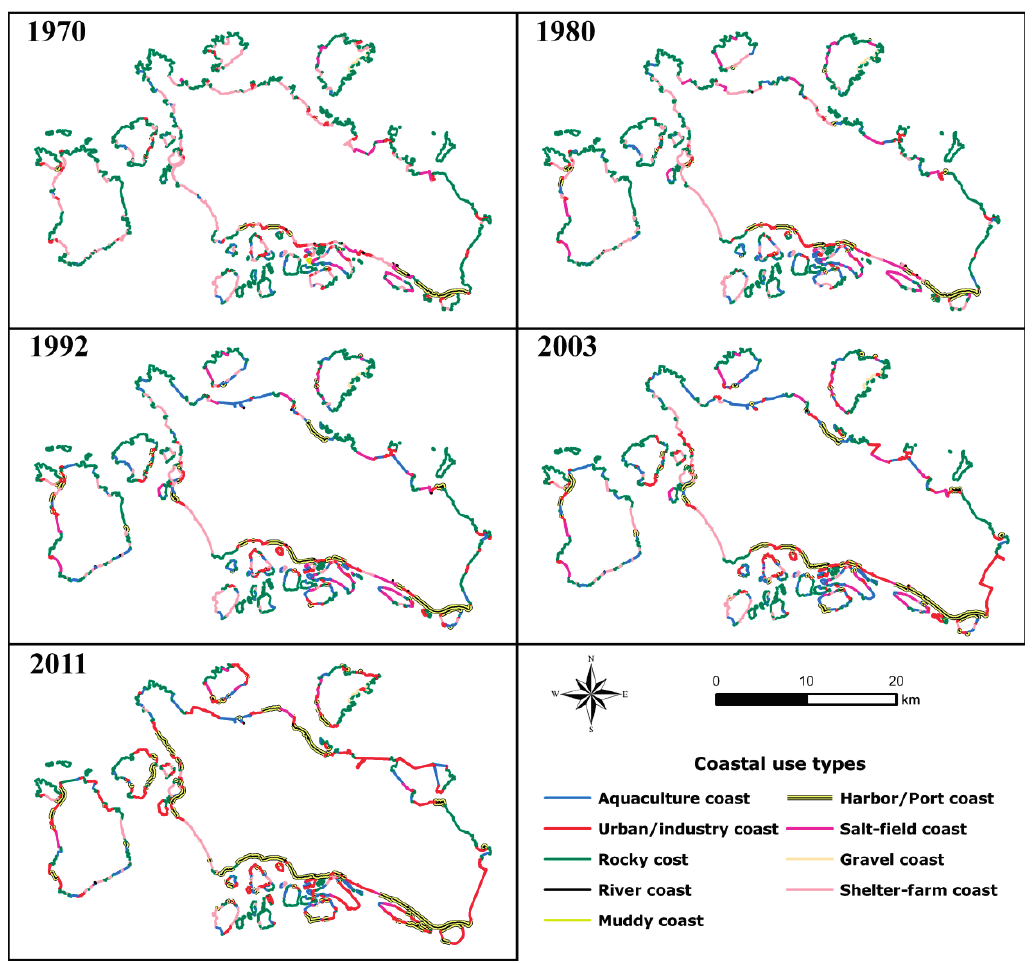
Figure 6. Classification of coastal use types during